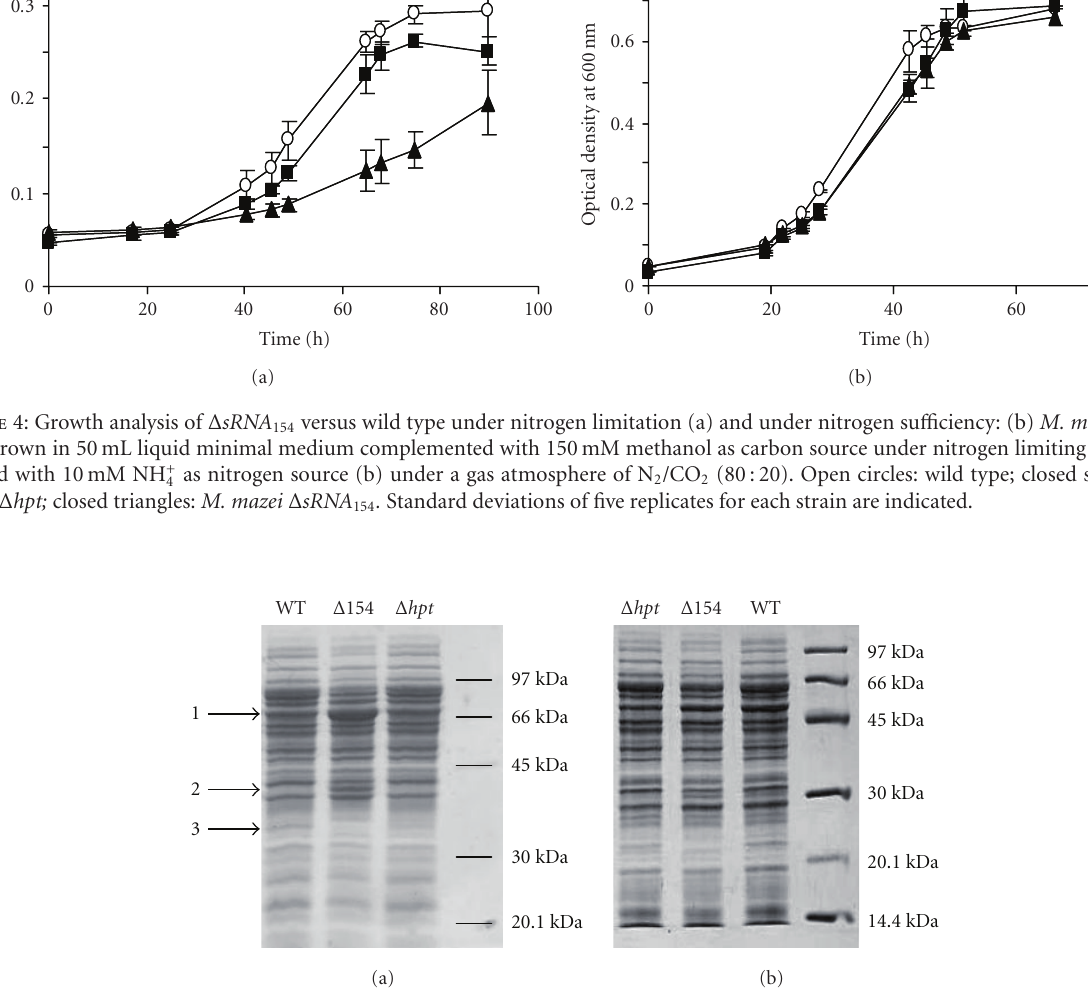
Figure 5: Analysis of protein expression pattern of Δ sRNA 154 versus wild type (a) under nitrogen limitation and (b) under nitrogen su ffi ciency. The M. mazei strains Δ sRNA 154 , Δ hpt, and wild type were grown in 50 mL medium under standard nitrogen-limiting conditions or under nitrogen su ffi ciency (see Figure 4). Cells were harvested in exponentially phase. Equal amounts of cell extracts (65 μ g) were applied to a 12% SDS-PA gel, which was subsequently stained with Coomassie blue. Arrows 1–3 indicate protein bands with di ff erential expression in M. mazei Δ sRNA 154 and wild-type strains. Marker: LMW marker GE